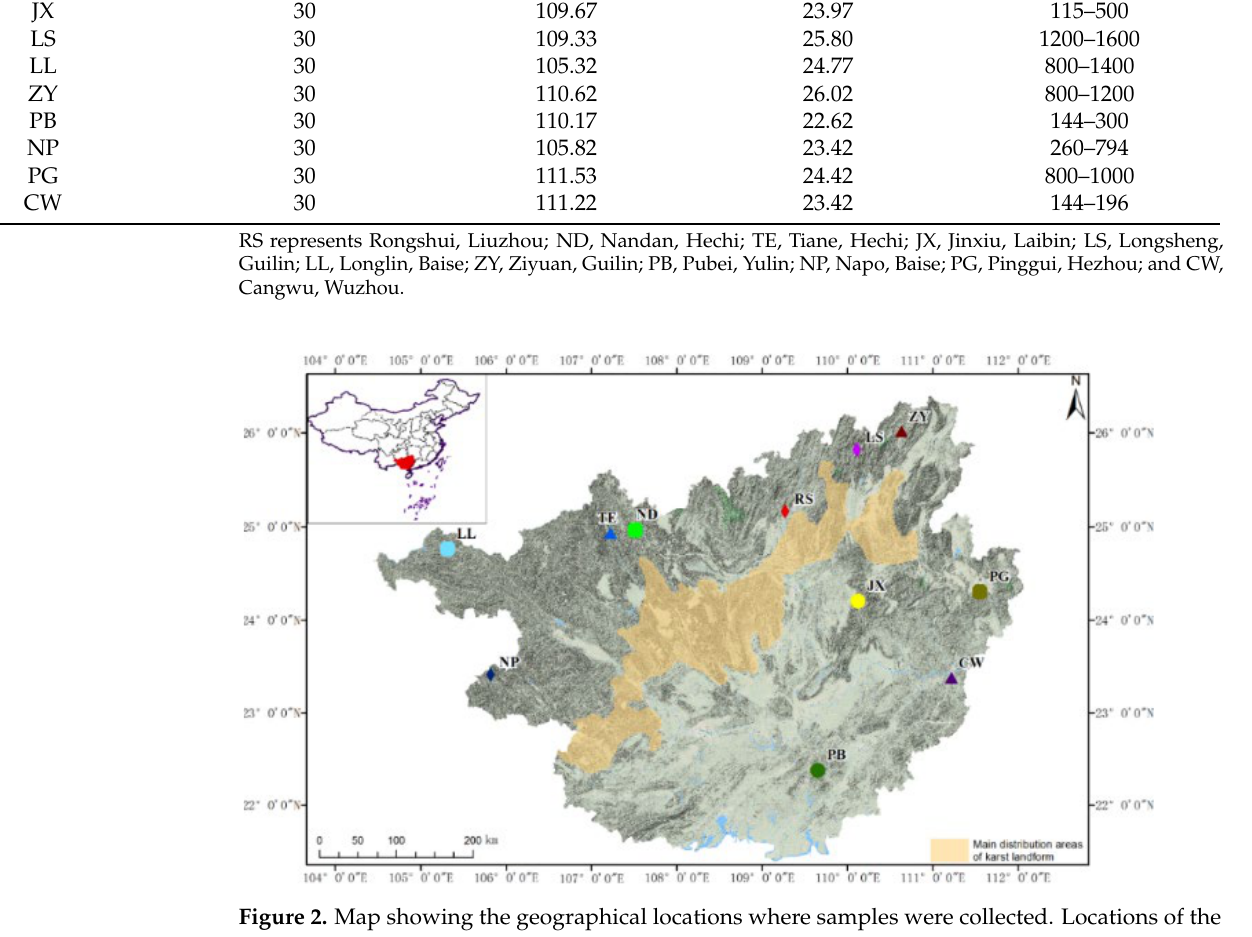
Figure 2. Map showing the geographical locations where samples were collected. Locations of the 11 sampled sites are shown by colorful markings (see Table 1 for the details of these sampled loca-